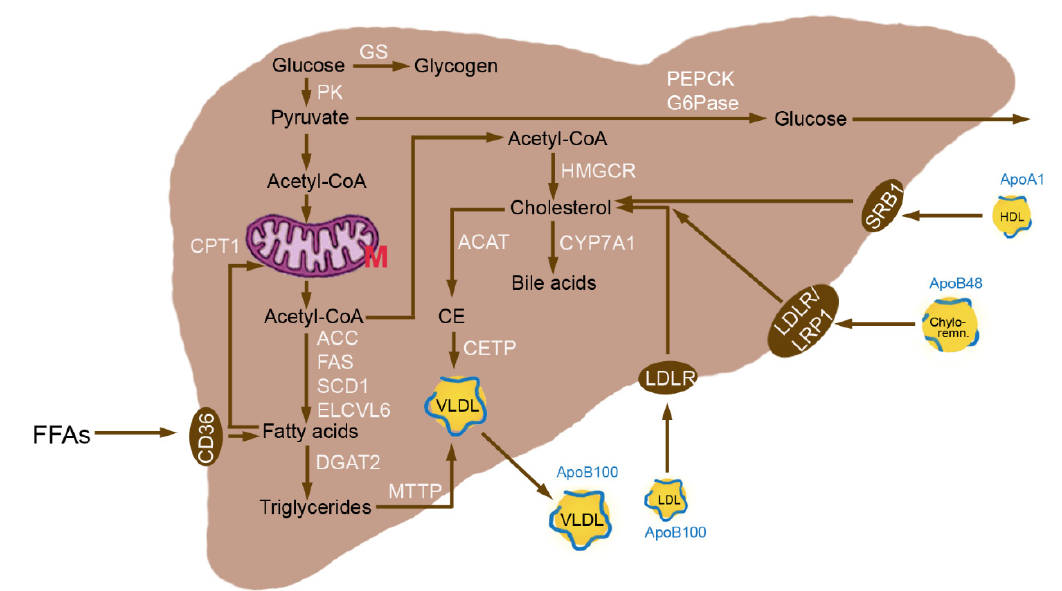
Figure 1. Enzymes relevant for the homeostasis of glucose, lipid and cholesterol homeostasis in healthy hepatocytes. Phosphoenolpyruvate Carboxykinase (PEPCK) converts phosphoenolpyruvate into oxaloacetate and is the rate-limiting step in gluconeogenesis. Pyruvate Kinase (PK) is the last step in glycolysis and transfers a phosphate group from phosphoenolpyruvate to pyruvate. Glucose may also be generated by Glucose-6-Phosphatase (G6Pase). The main role in glycogenesis is exerted by Glycogen Synthase (GS). Tricarboxylic Acid cycle (TCA) and β -oxidation of Fatty Acids (FAs) in the mitochondria serve for energy production. Activity of Carnitine Palmitoyl Transferase 1 (CPT1) determines the extent of β -oxidation. Lipogenesis is regulated through action of Acetyl-CoA Carboxylase 1 (ACC), Fatty Acid Synthase (FAS), Stearoyl-CoA Desaturase (SCD1) and Elongation of Very-Long chain fatty acids protein 6 (ELOVL6). Diacylglycerol O-Acyltransferase 2 (DGAT2) catalyzes the formation of Triglycerides (TGs) from diacylglycerol and fatty acid-CoA. Microsomal Triglyceride Transfer Protein (MTTP) is essential for the assembly with apoB100 in the synthesis of Very-Low-Density Lipoprotein (VLDL). Cholesterol may be synthesized de novo from Acetyl-CoA by β -Hydroxy- β -Methylglutaryl Coenzyme A Reductase (HMGCR) as rate-limiting step in the synthesis. Acyl-CoA Cholesterol Acyltransferase (ACAT) produces Cholesterol Esters (CE) that are integrated into VLDL by Cholesteryl Ester Transfer Protein (CETP). Cholesterol can also be metabolized to bile acids by the action of Cholesterol 7a-hydrolase (CYP7A1). Cholesterol may be taken up as Low- Density Lipoprotein (LDL) cholesterol by LDL Receptor (LDLR), as HDL cholesterol by scavenger receptor class B type 1 (SRB1) and as Chylomicron remnants (Chylo-remn.) by LDLR in humans and LDLR-related Protein 1 (LRP1) in rodents. Surface proteins are Apolipoprotein (Apo)B48 for chylomicron remnants, ApoB100 for VLDL and LDL, and ApoA1 for HDL cholesterol particles. Free Fatty Acids (FFAs) can be taken up by CD36, also termed Fatty Acid Translocase (FAT). Abbreviation: M,